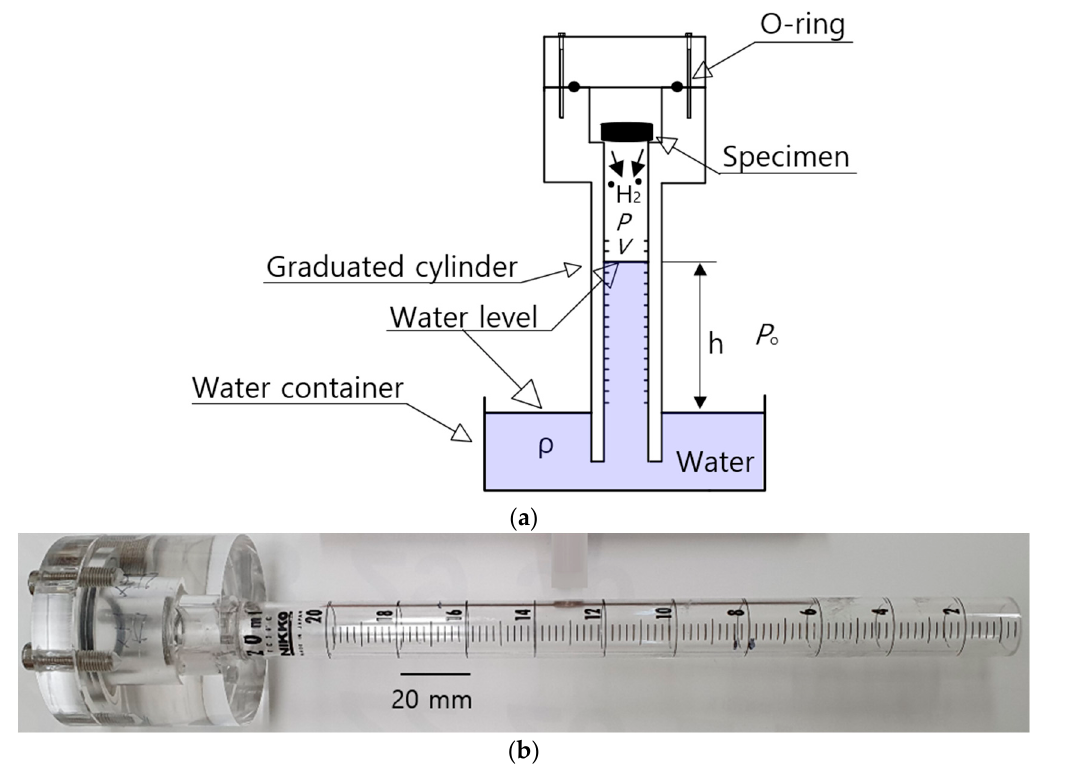
Figure 1. ( a ) Schematic diagram of the VAT system in which the cylinder is standing upright. The blue part indicates the distilled water filled in the water container and cylinder. ( b ) Photograph of a stretched graduated cylinder with a capacity of 20 mL.